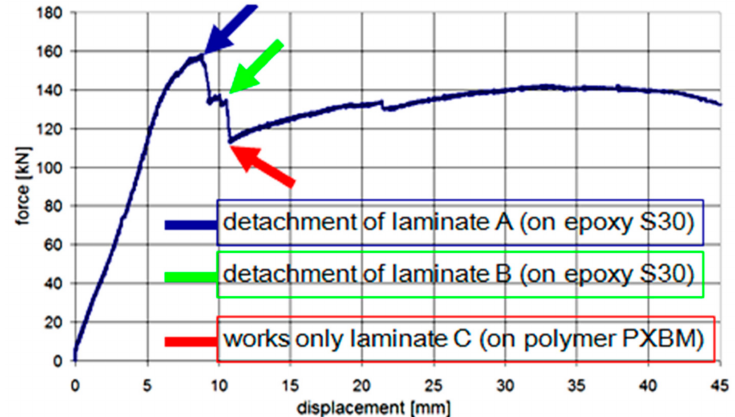
Figure 9. The force-displacement (F–d2) diagram presenting steps of the beam